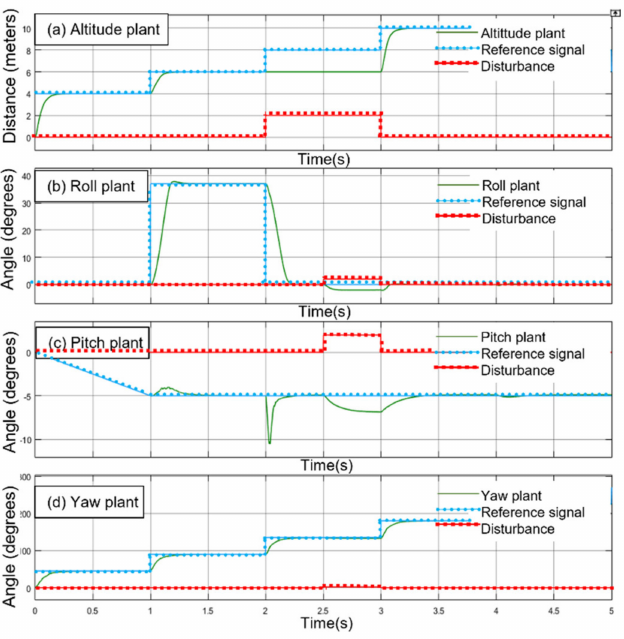
Figure 18. Autotuned GA–Sugeno Fuzzy–PD. ( a ) Altitude plant, ( b ) roll plant, ( c ) pitch plant, ( d ) yaw